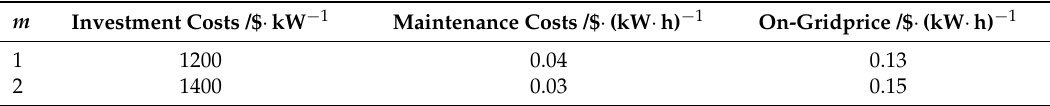
Table 2. The per-unit capacity Cost of DGs.